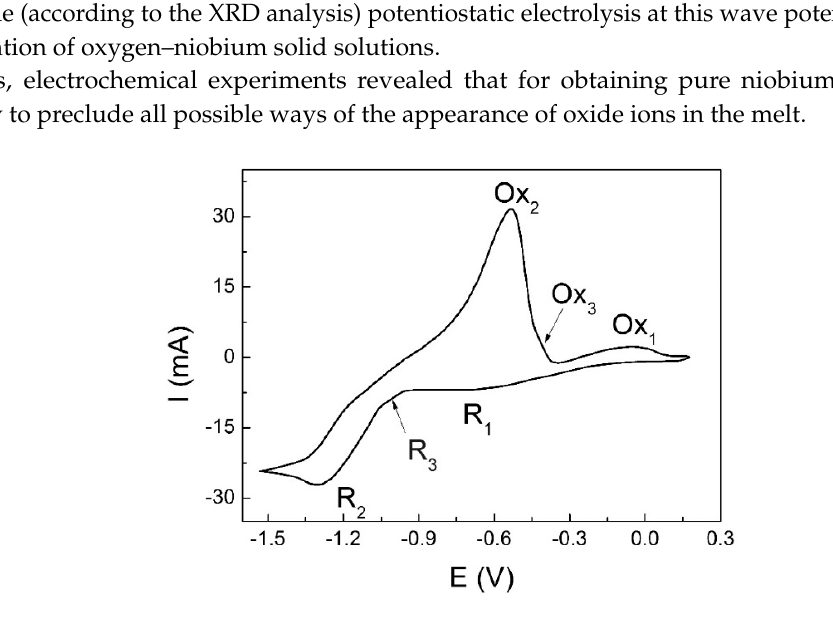
Figure 4. The cyclic voltammogram obtained in the NaCl–KCl–NaF–K 2 NbF 7 melt. ν = 0.1 V·s − 1 , t = 750 ° С , C K = 5.05 × 10 − 4 mol · cm − 3 , C Na = 1.25 × 10 − 5 mol · cm − 3 . 2 O 2 NbF 7